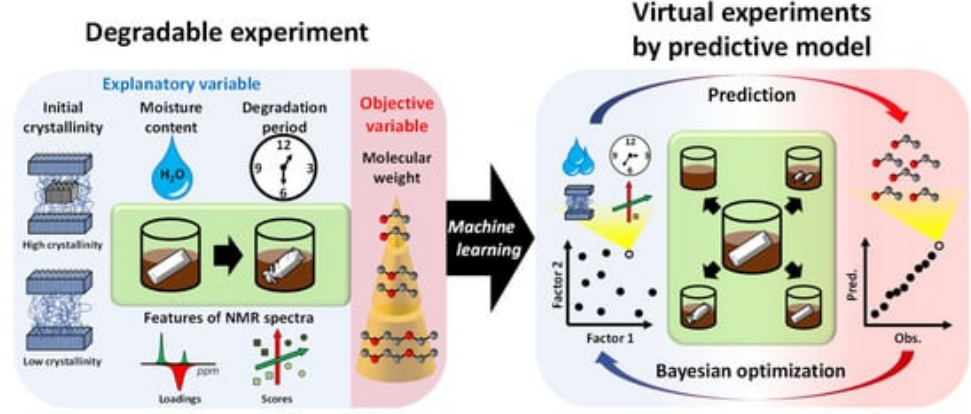
Figure 14. Real and virtual degradable experiments according to the study of Yamawaki et al.